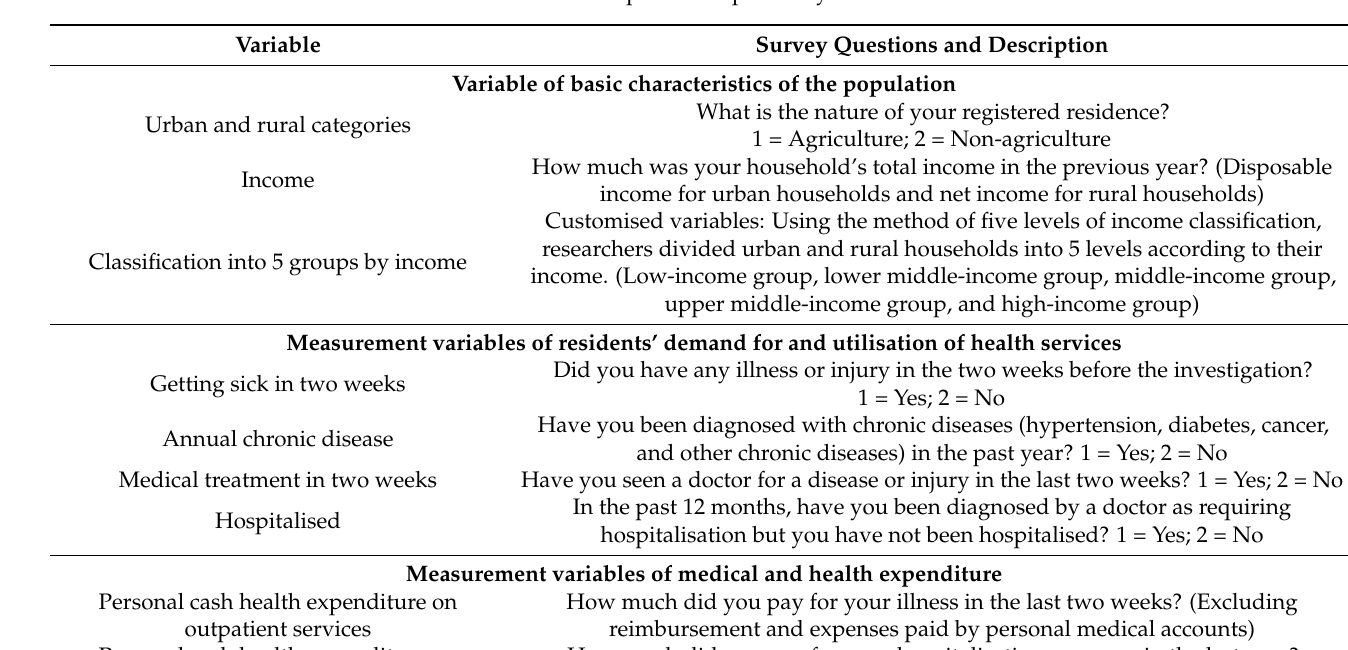
Table 1. Description of explanatory